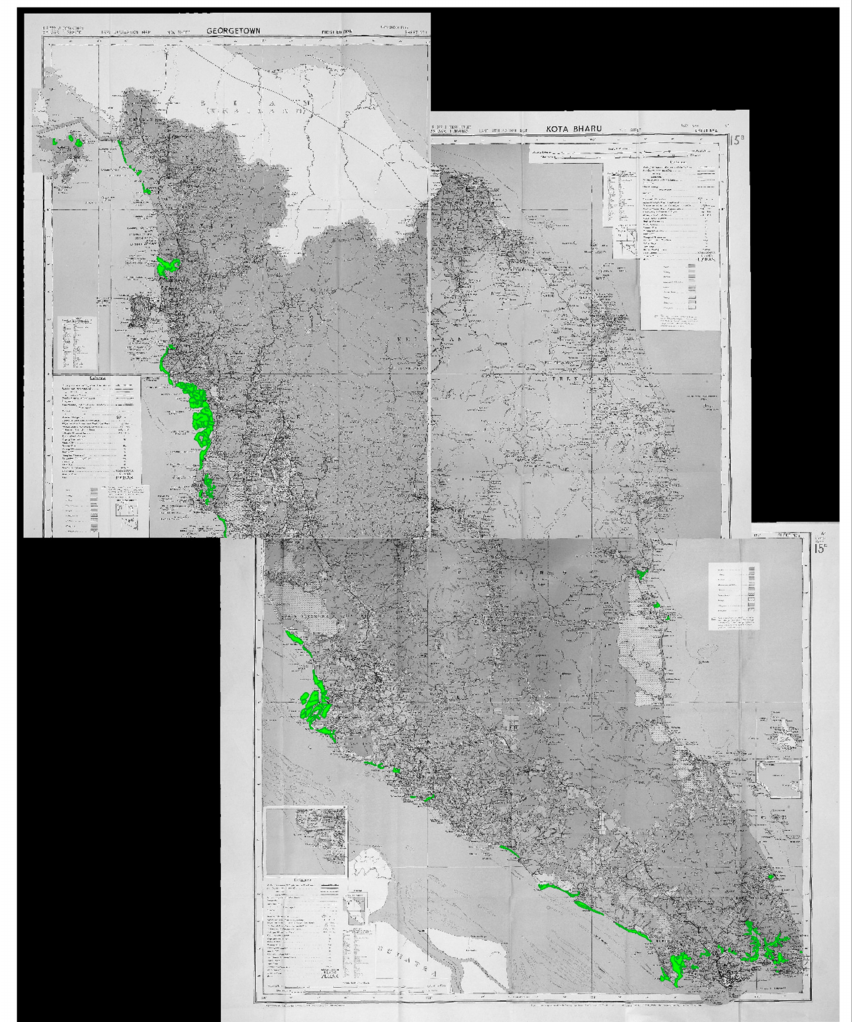
Figure 4. Mangrove cover classification on Land Utilization Maps—Georgetown, Kota Bharu